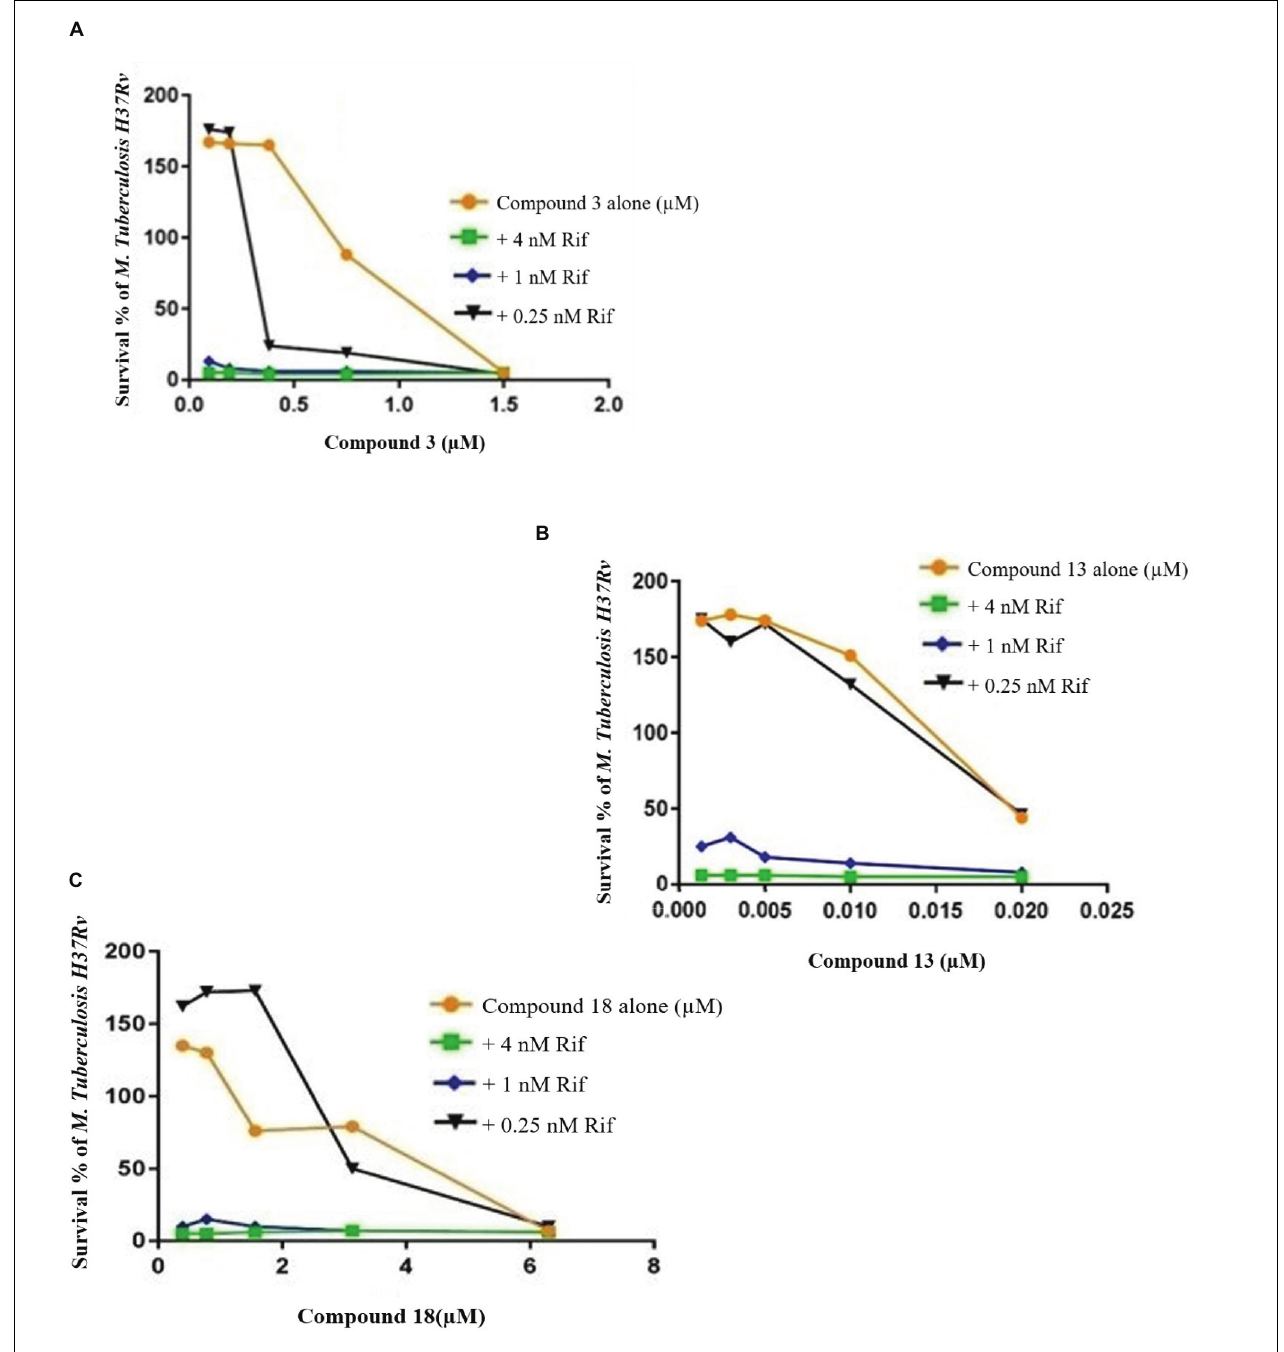
FIGURE 6 | Checkerboard study between rifampicin and 3 (A) , 13 (B) , and 18 (C) . TB. H37Rv was incubated with varying concentrations of rifampicin (Rif) together with dilutions of the synthetic drugs 3 (A) , 13 (B) , and 18 (C) . Graph displays the mean survival of triplicate samples and represents data from three independent